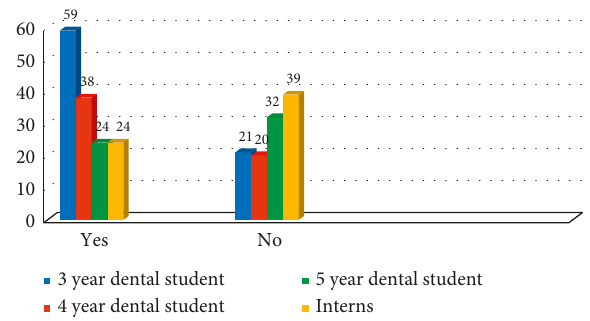
31.69 with P 0 . 01). (cid:31) ≤